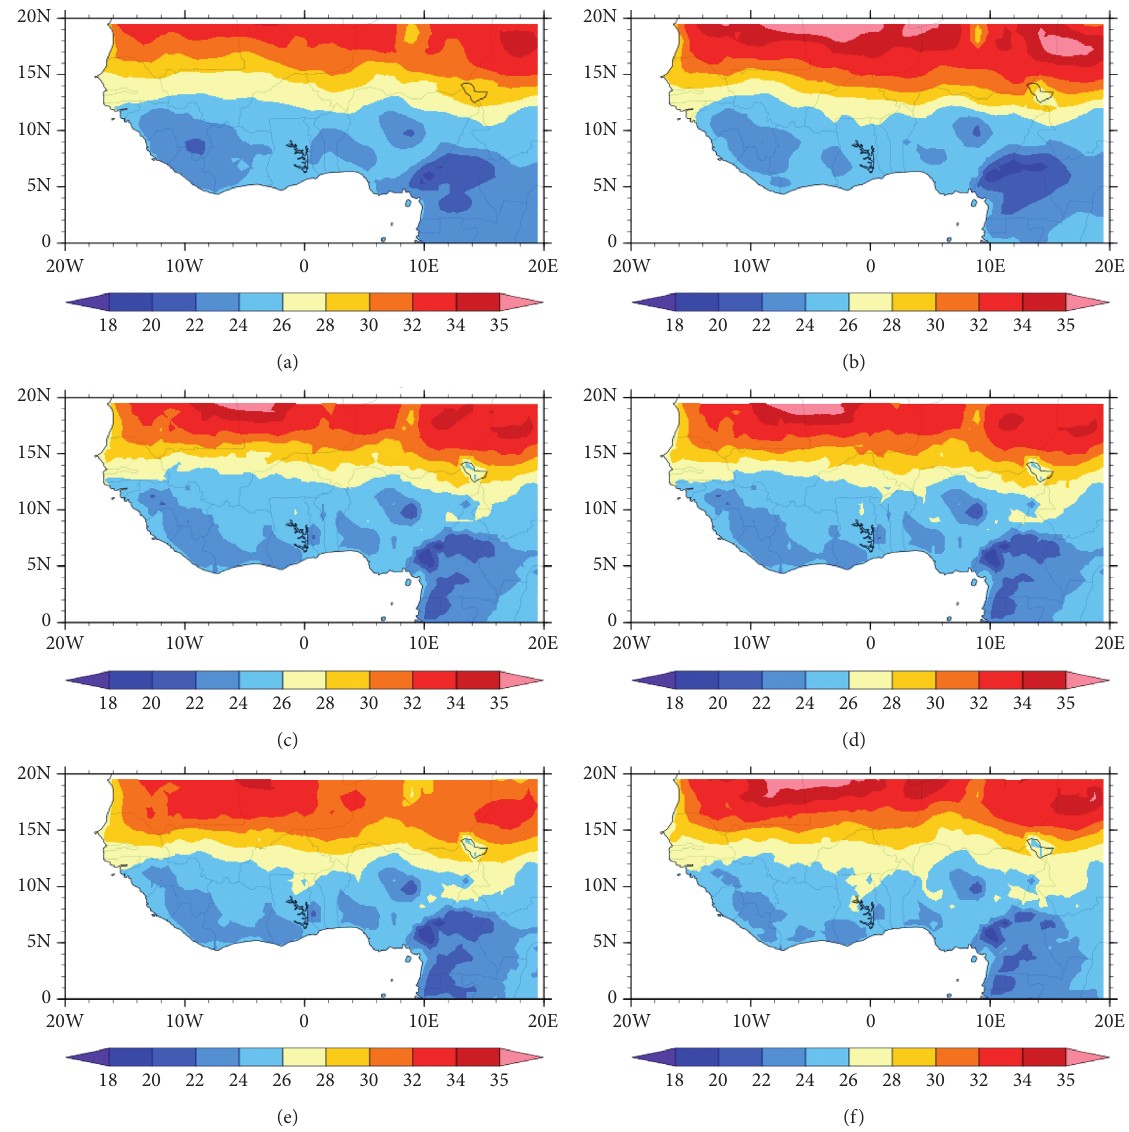
Figure 2: Spatial distribution of average 2 meter surface temperature ( ° C) for July 16 th –Sept 29 th , 2012. (a) ERA-interim. (b) FNL. (c) Noah- MP groundwater option. (d) Noah-MP. (e) Noah. (f)